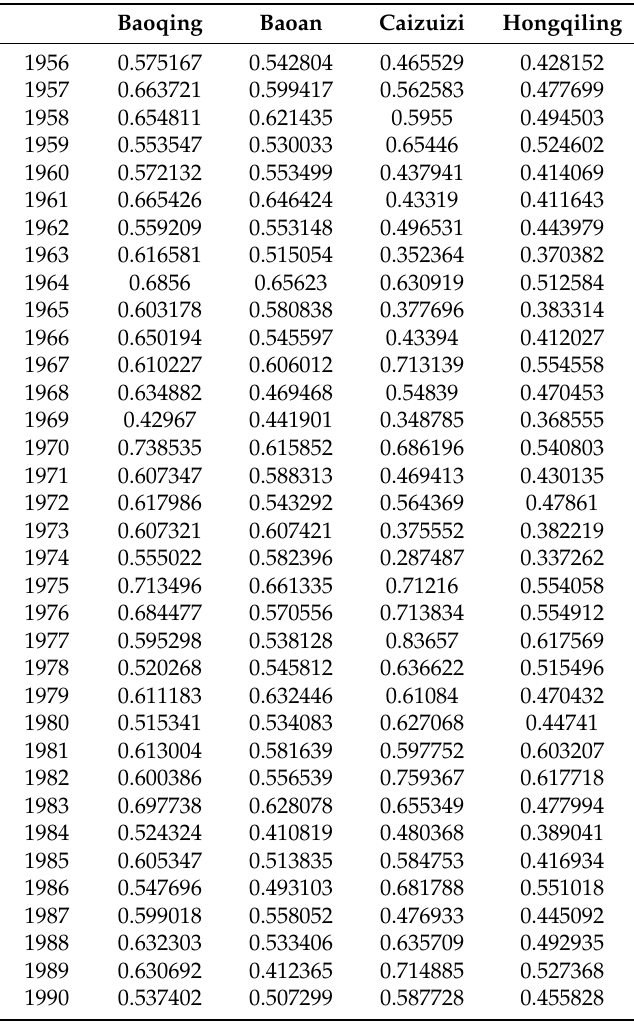
Table A3. GI of the four